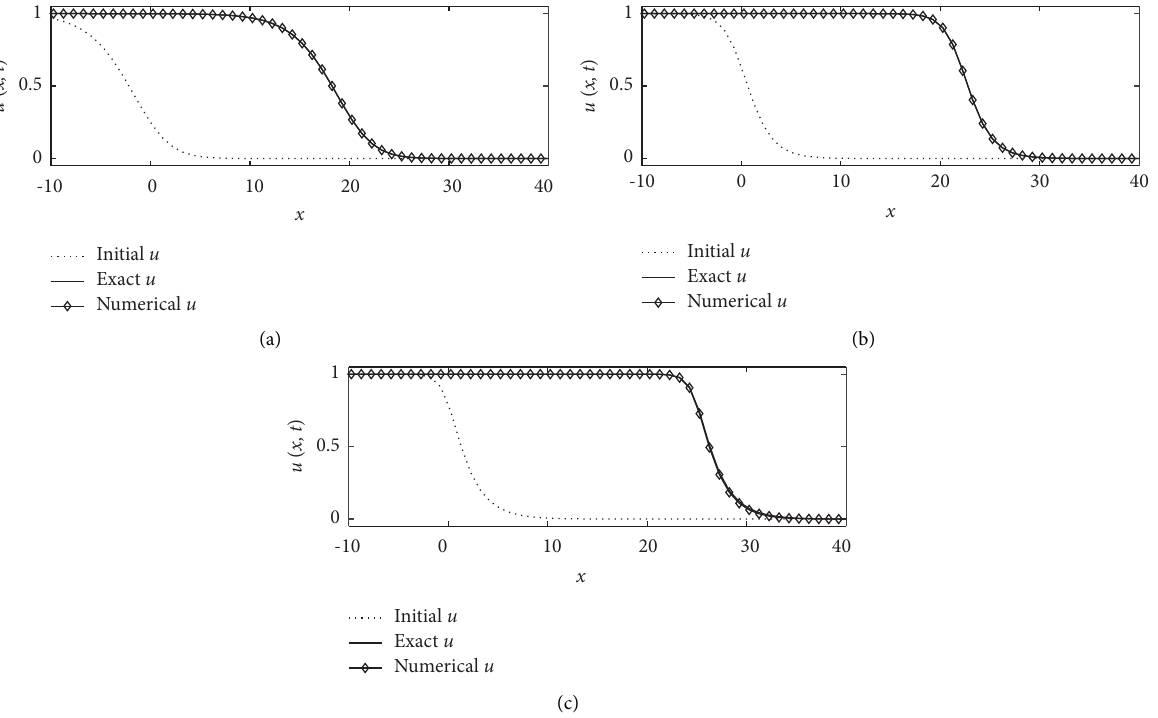
Figure 11: Numerical solutions with initial condition equation (13) for different p values. (a–c) Solutions with p � 1 , 3, and 6,